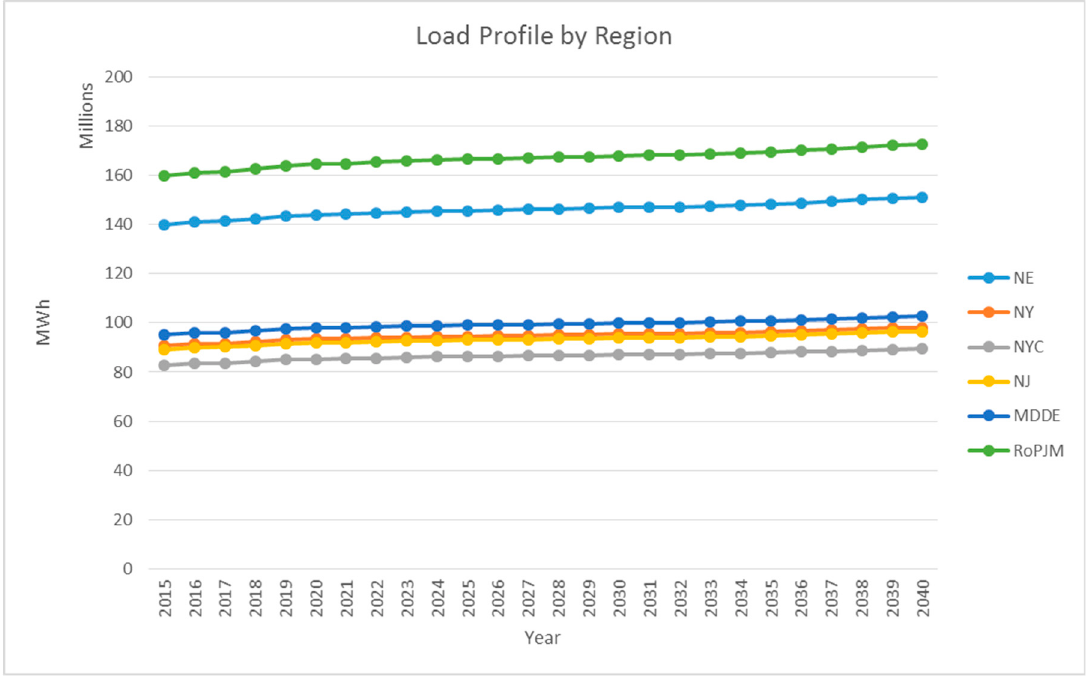
Figure A1. Load Profile by Region (U.S. Energy Information Administration, 2015).